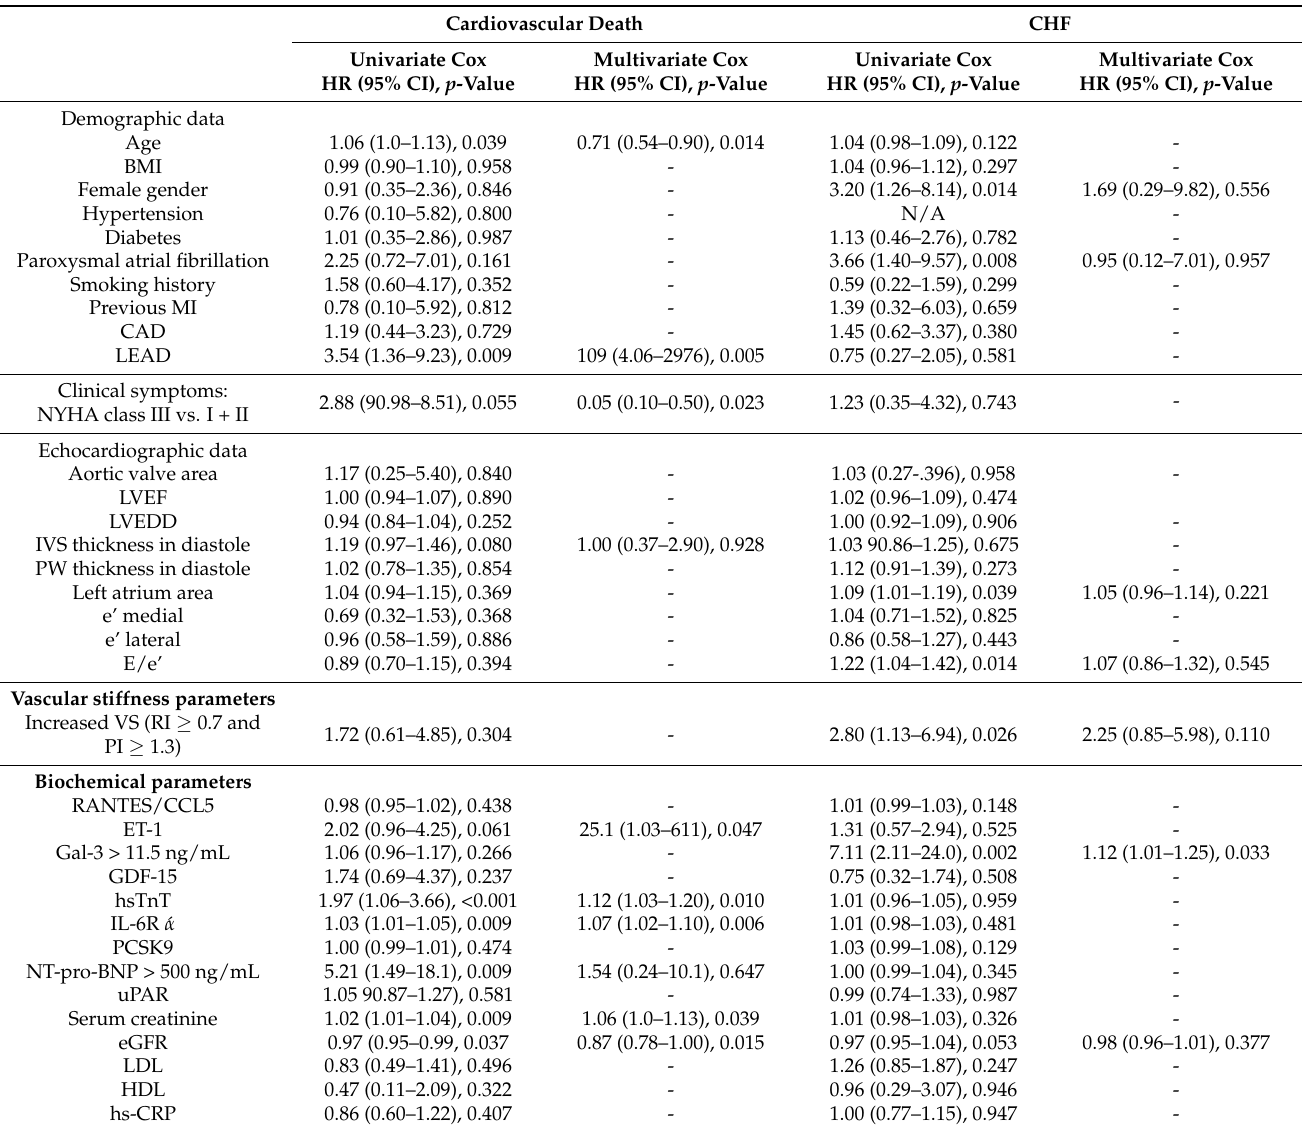
Table 4. The univariate and multivariate Cox proportional hazard analysis of biomarkers associated with cardiovascular death and chronic heart failure exacerbation